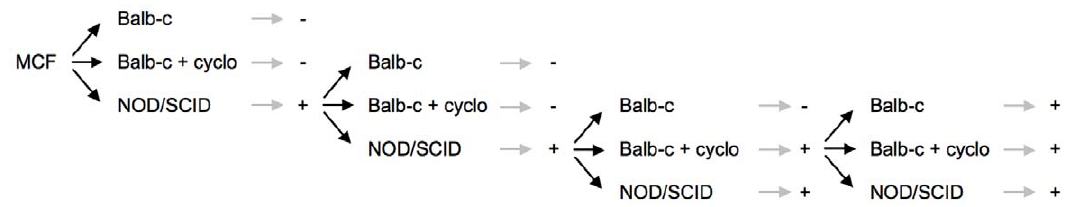
Figure 4. Infectivity of TRUM183:13–29 cell-line through mice passages. 10 7 in vitro differentiated MCF or a volume corresponding to 10 7 parasites of infected mice blood were injected in Balb-c, Balb-c pretreated with cyclophosphamide or NOD/SCID mice. Development of parasitaemia was monitored by microscopic observation of mice blood every two days during 2 months. 2 means that no parasite could be observed during the time period of observation, + means that parasitaemia developed during the time period of